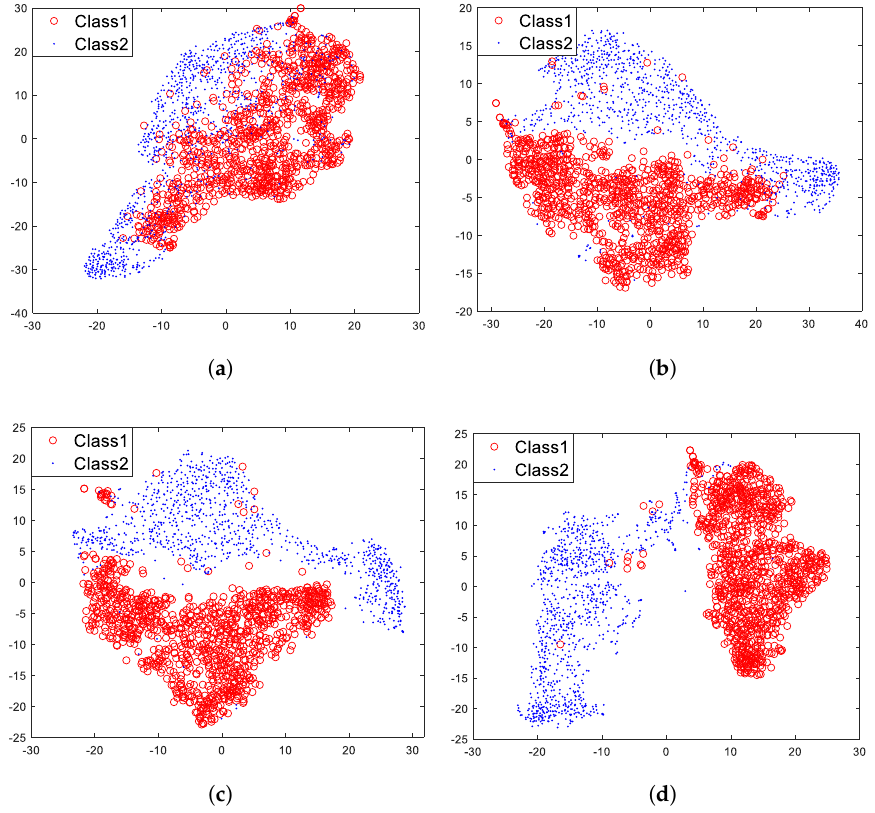
Figure 13. Feature visualization under unsupervised pre-training. ( a ) Layer 1. ( b ) Layer 2. ( c ) Layer 3. ( d ) Layer